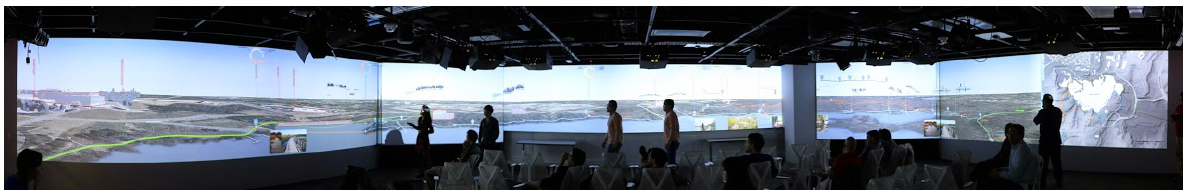
Figure 7. Landscape architecture students presenting their design for a trail system in the Hunt Library Teaching and Visualization